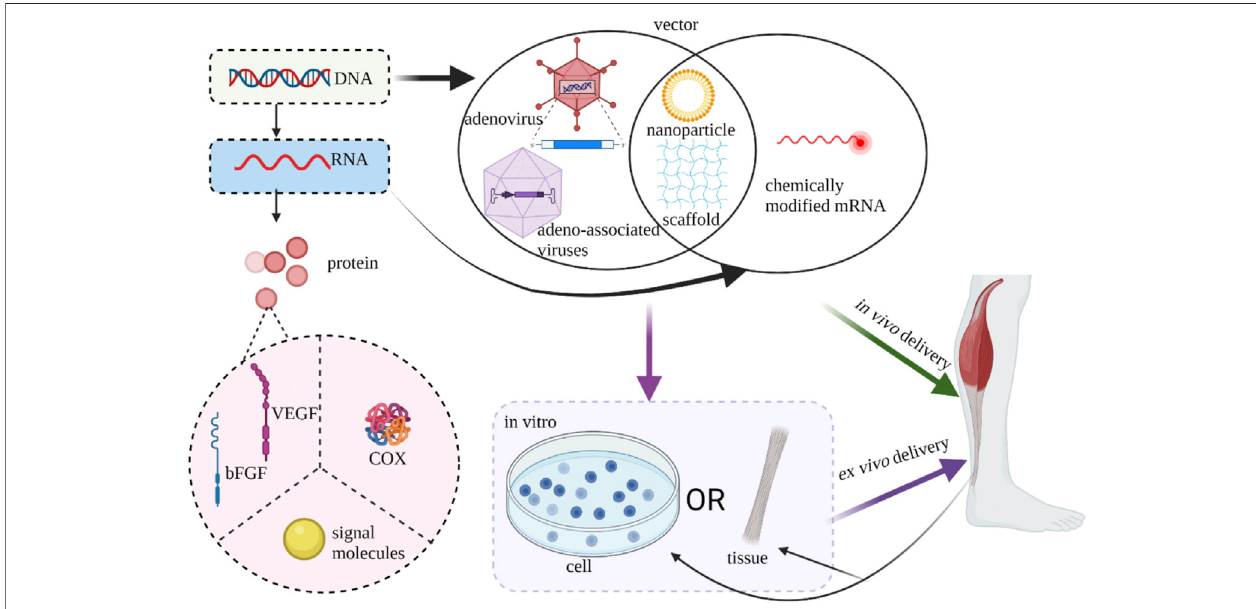
FIGURE 5 | Current strategies of gene therapy of tendon/ligament (Created with